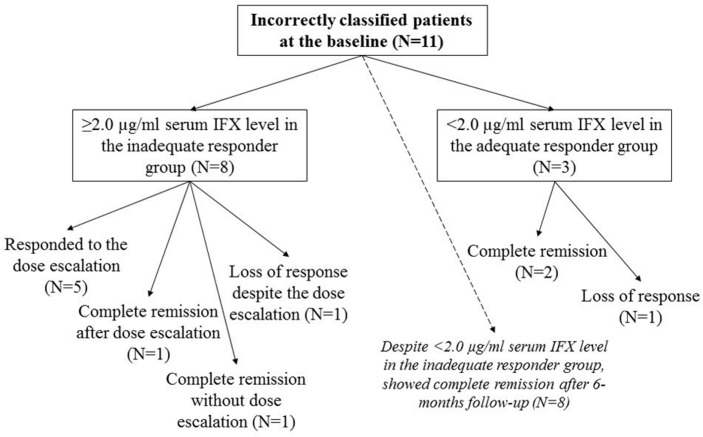
Incorrectly classified cases by serum infliximab trough levels after 6-months follow-up.